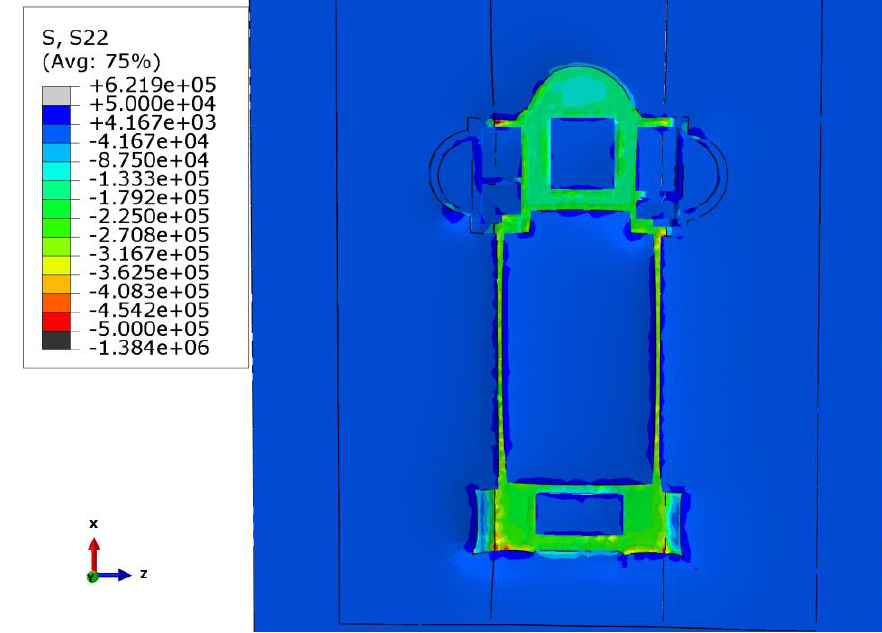
Figure 13. Vertical contact stresses in the soil at the idealized (flat) bottom surface (N/m 2 ).